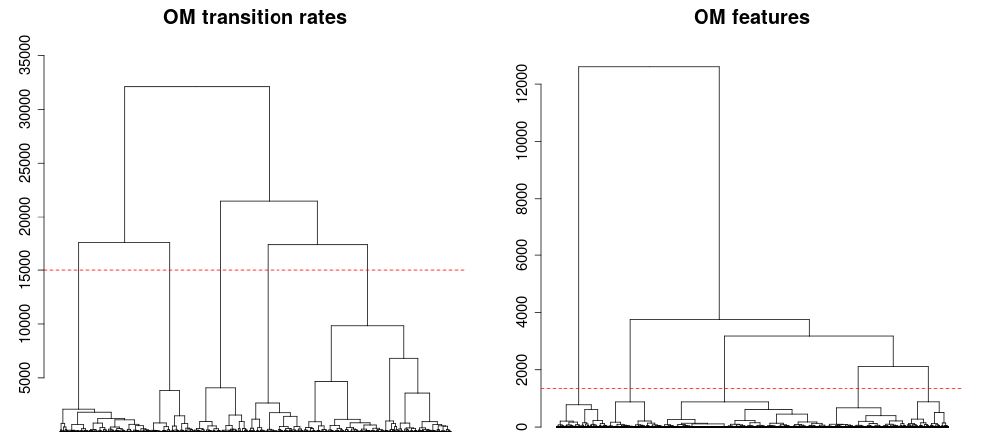
Figure 7. Dendrograms of cluster analysis. Longest common subsequence (LCS), longest common prefix (LCP), and optimal matching (OM). The vertical axis refers to the distance between clusters.